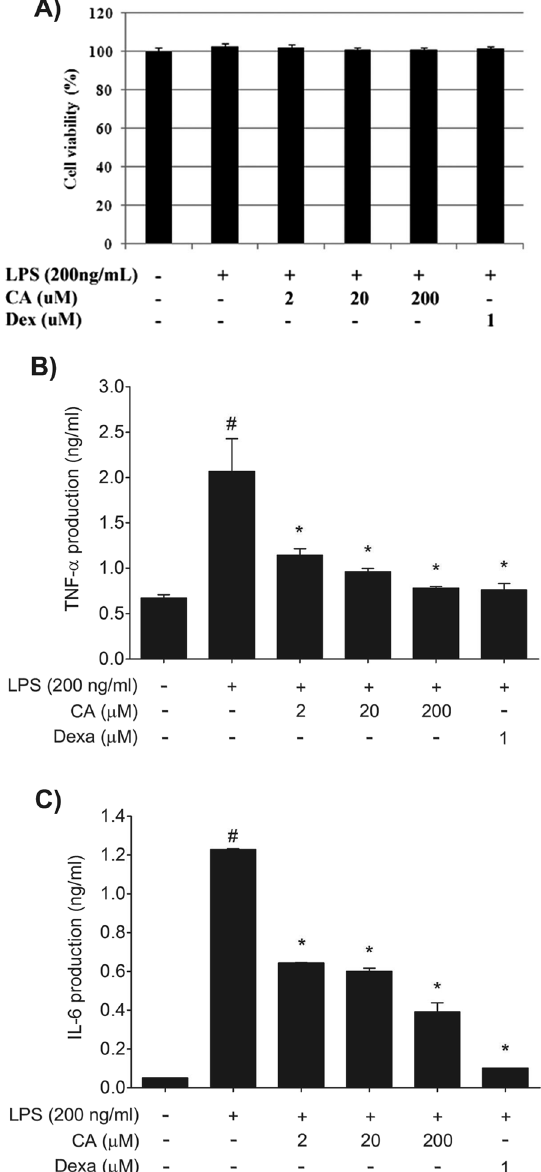
Fig. 5 Effect of CA on IL‑6 and TNF‑α production in LPS‑stimulated peritoneal macrophages. Cells (3 10 5 cell/well) were pretreated with × various concentrations of CA for 1 h and subsequently stimulated with LPS (200 ng/ml) for 24 h. Dexa (1 μM) was used as a positive control. A Cell viability was determined by an MTT assay. B and C The levels of TNF‑α and IL‑6 in cell supernatants was measured using ELISA. Values are the mean S.D. of duplicate determinations from ± three separate experiments ( # p < 0.05 vs. un‑stimulated cells, * p < 0.05 vs. LPS‑ stimulated